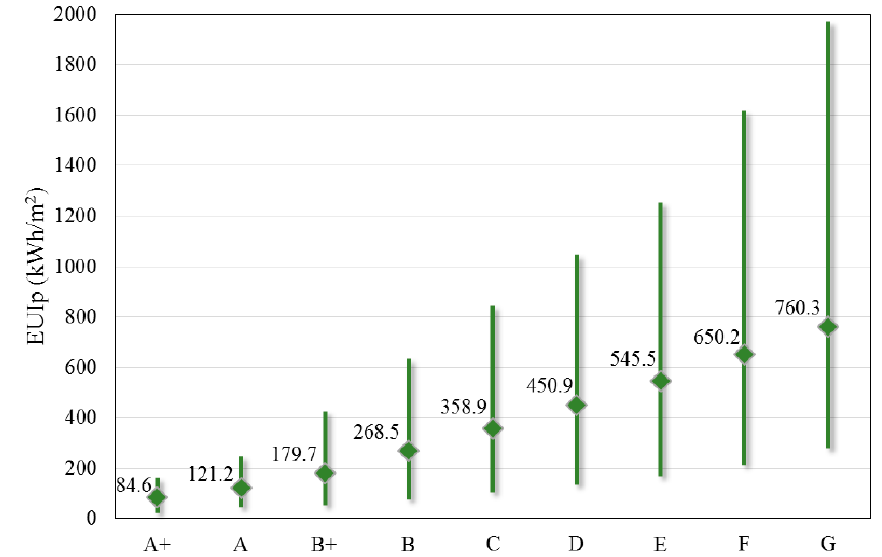
Figure 7. Calculated maximum, minimum and average (diamond) total primary energy use intensity for the different energy classes.